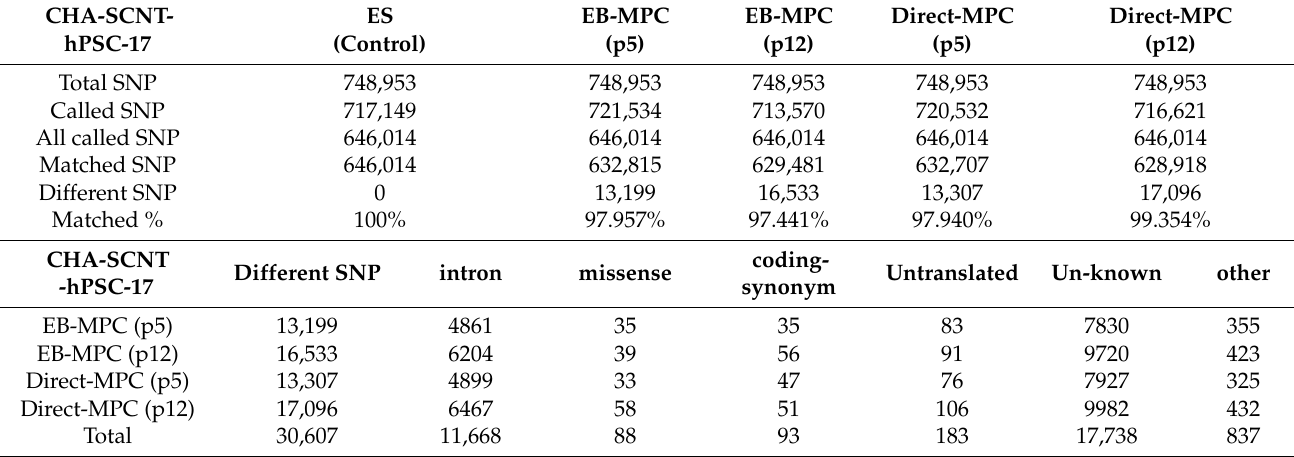
Table 2. SNP analysis of CHA-SCNT-hRSC-17 derived MPCs by array-based comparative genomic hybridization. CHA-SCNT-